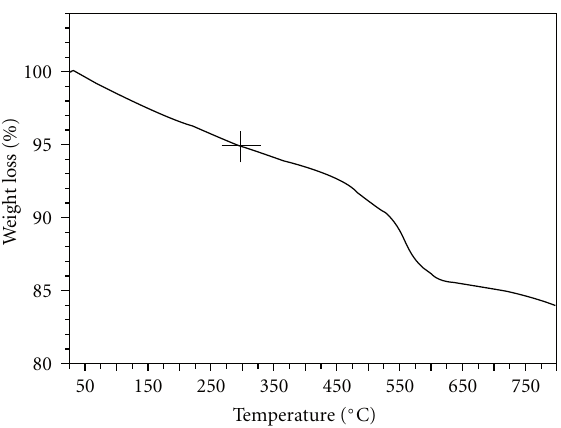
F 1: TGA pro�le of mixed CuMn